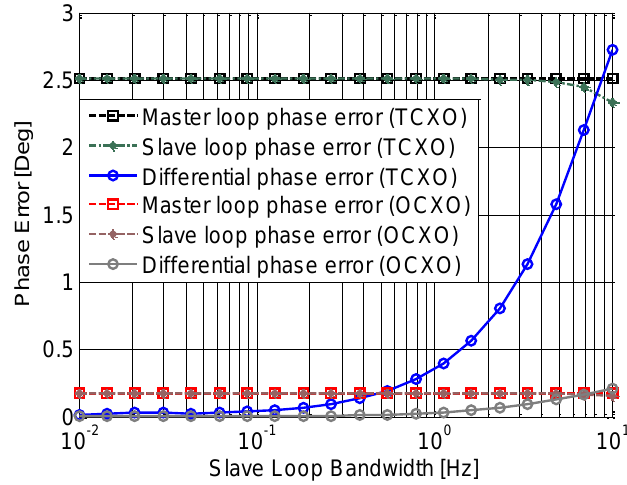
Figure 8. Phase jitter induced by Allan Deviation phase noise with an independent loop.